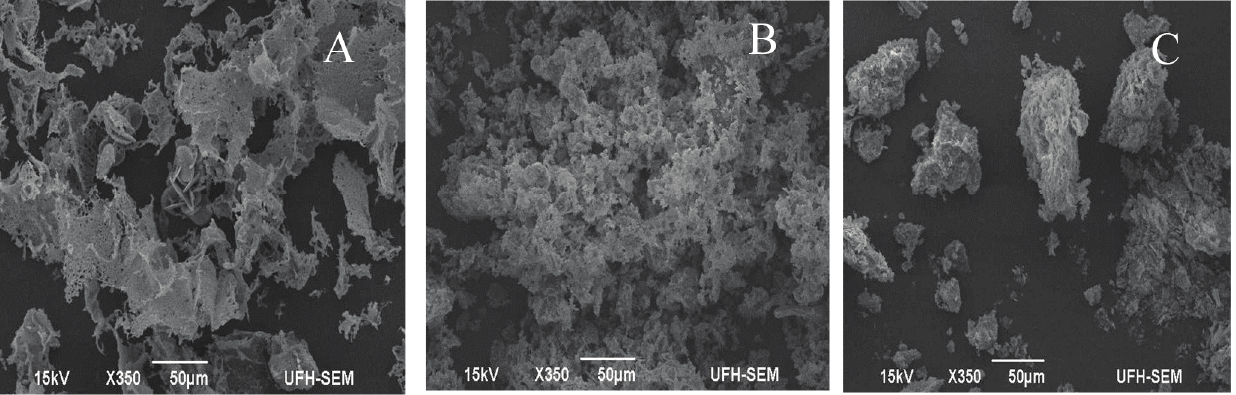
Figure 3. SEM imaging of purified MBF-UFH produced by Bacillus sp. AEMREG7 ( A ), kaolin clay particles ( B ) and kaolin clay suspension flocculated with MBF-UFH ( C